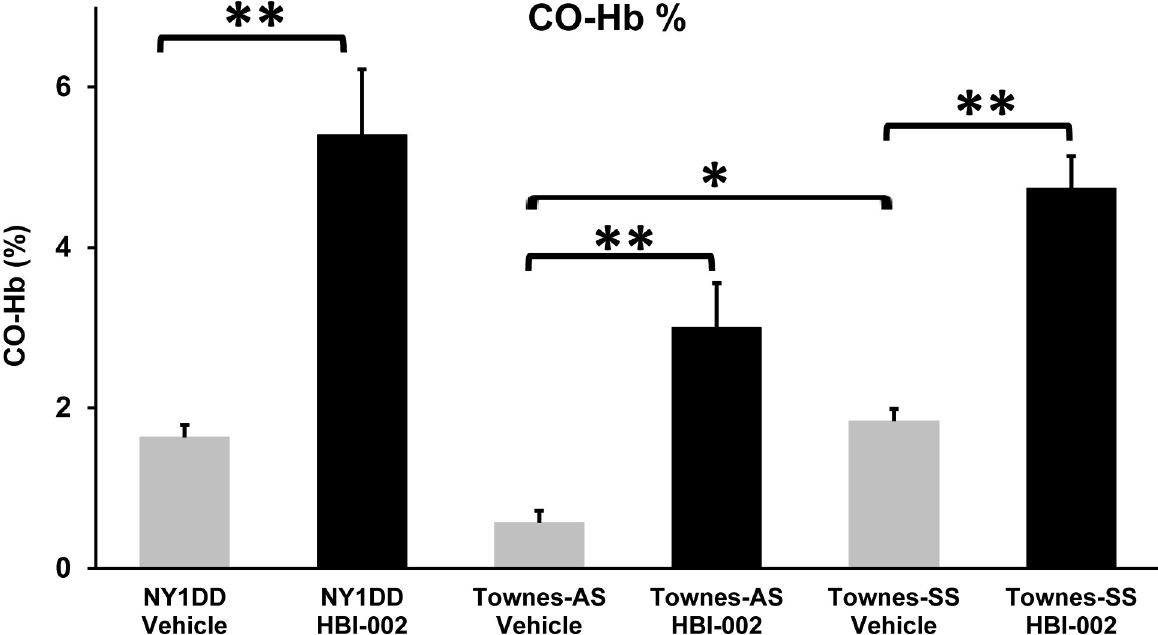
Fig 1. Circulating CO-Hb levels in mice after gavage with HBI-002. NY1DD and Townes-AS and SS mice (n = 3/group) were gavaged once with HBI-002 or vehicle (10 ml/kg) and venous blood was collected 5 min after gavage from the inferior vena cava for measurement of CO-Hb. Bar values represent means + SD. �� P < 0.01 for vehicle versus HBI-002 and � p < 0.05 for Townes-AS versus SS. Differences between groups were analyzed using One Way ANOVA (Holm-Sidak method).